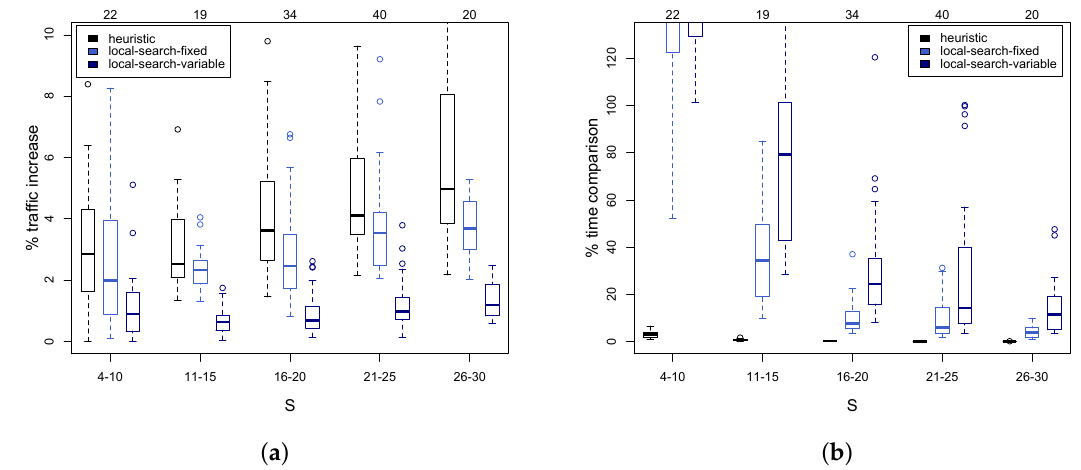
Figure 6. Performance comparison of the heuristic solutions in terms of control traffic and computation time. Results are grouped by S . Top axis gives the number of network topology samples for each S . ( a ) Percentage of control traffic increase for the heuristic solutions, with respect to the optimal, averaged over all f β s / β c values. ( b ) Time required by the heuristic solutions, as a percentage fraction of the optimal solution